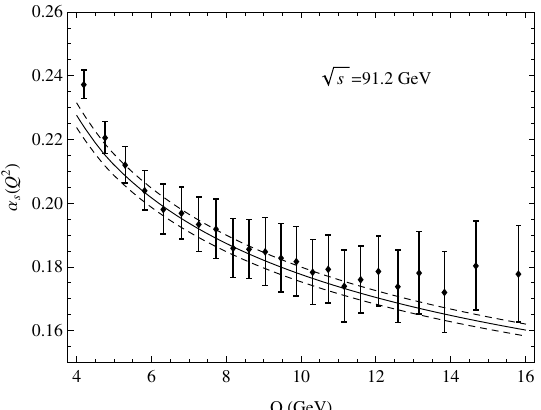
√ s = 91 . 2 GeV. As ( M 2 ) = 0 . 1179 [28], and two s Z